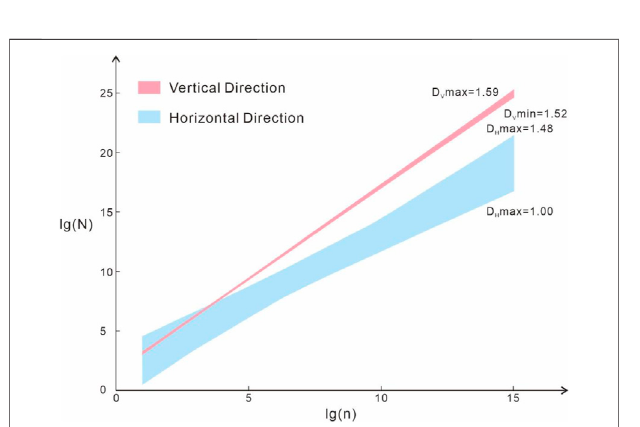
FIGURE 5 | Characteristics of vertical and horizontal fractal curves of imaging log.